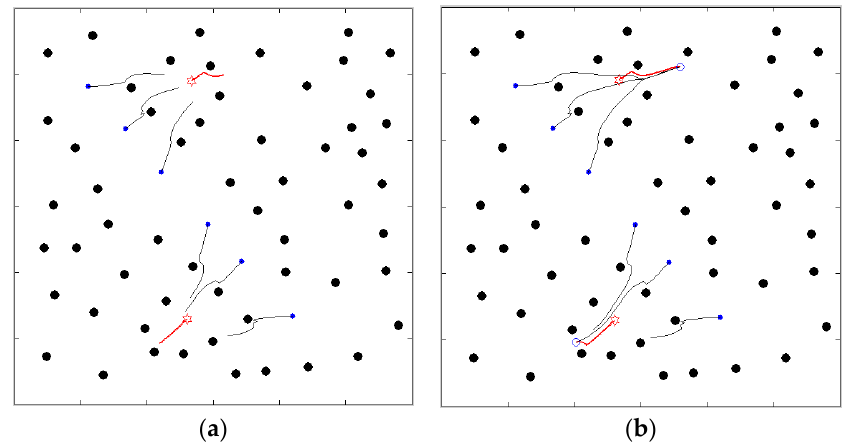
Figure 5. Multi-target search of initial position of multi robot on diagonal. ( a ) t = 20, ( b ) t = 36.